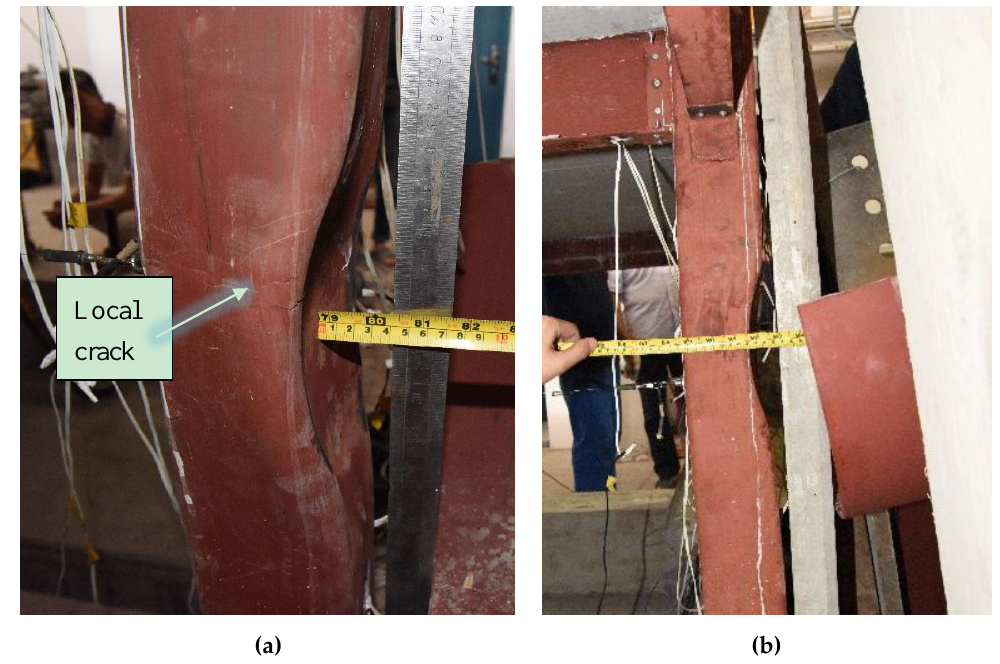
Figure 4. Photo of the impacted column after case G3: ( a ) Model A; and ( b ) Model B.